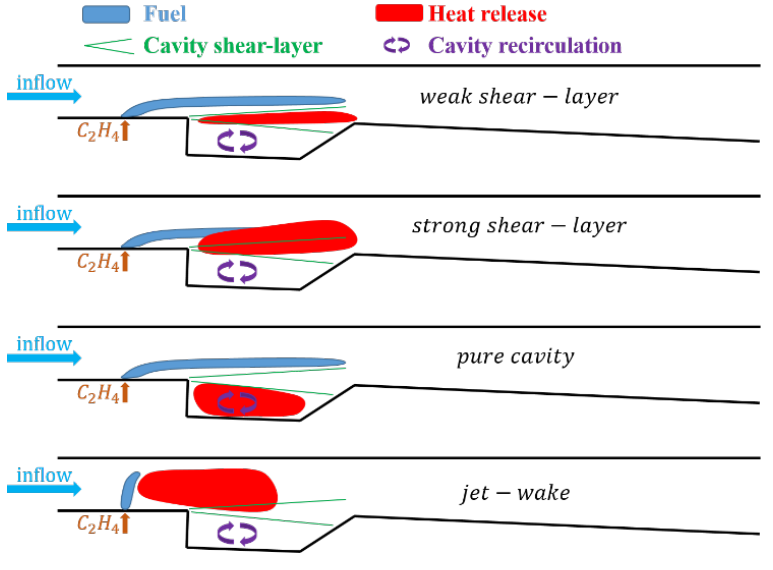
Figure 21. Mechanism of the flame stabilization mode. There are three regions in the cavity flame stabilization structure: the flow region inside the cavity, the shear layer region, and the jet wake region, respectively. The three